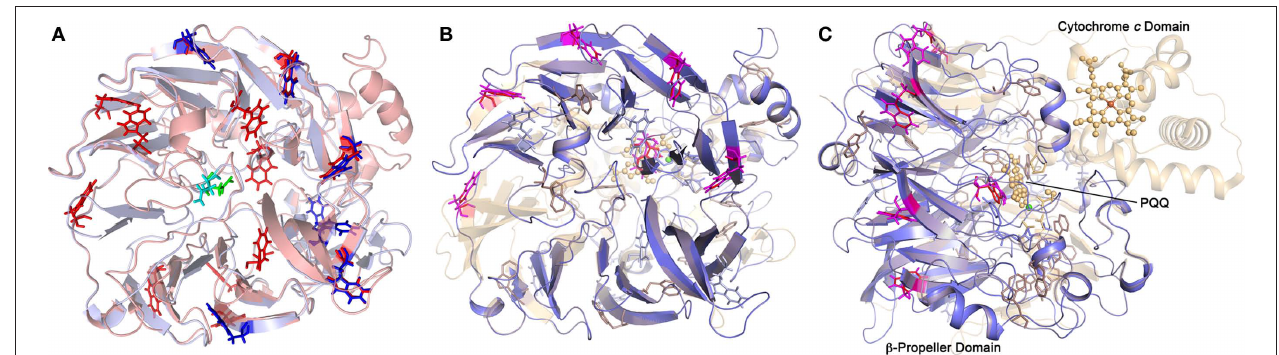
glycosylated Asn resdidue of TTH1 is highlighted in green, the corresponding Asn of TTH2 in cyan. (B,C) Overlay of the TTH1 model (blue) with the 1kv9 template (red), top and side views; spheres, PQQ and cytochrome c molecules; green sphere, Ca 2 + ion; brown sphere, iron ion; the tryptophane residues are highlighted